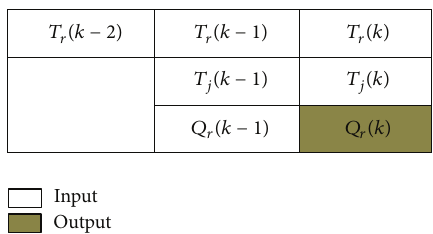
Figure 5: Input/output mapping of the SVM heat release estimator.